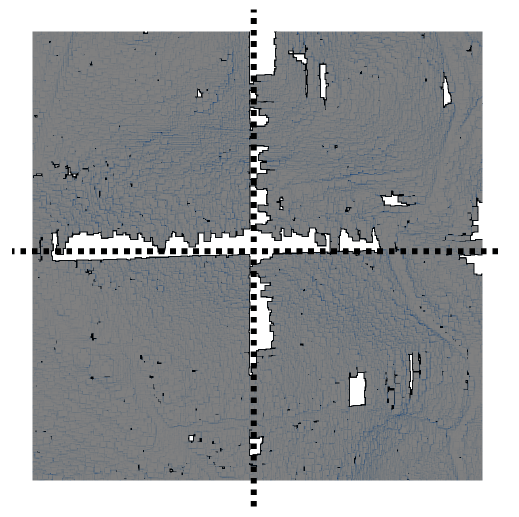
Figure 2. Raster displaying only ground points. The raster was obtained by independently filtering four adjacent zones and joining the results. Dotted lines highlight zone boundaries.